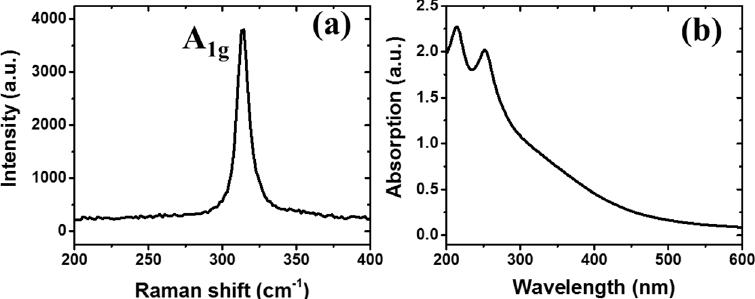
Figure 1. Raman ( a ) and UV–visible absorption spectra ( b ) of SnS 2